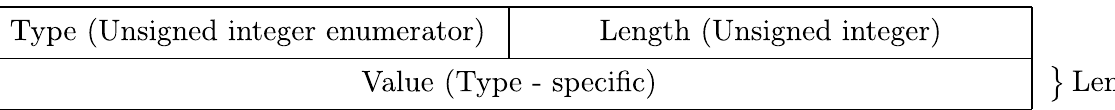
Fig. 3 TLV packet formats. The mapping between the type name and 16-bit unsigned integer value can be found in the IEEE standard. Type and Length are represented by two unsigned 16-bit integers. Value interpretation is dependent from the Type field and its length is based on the homonym field, interpreted as the number of